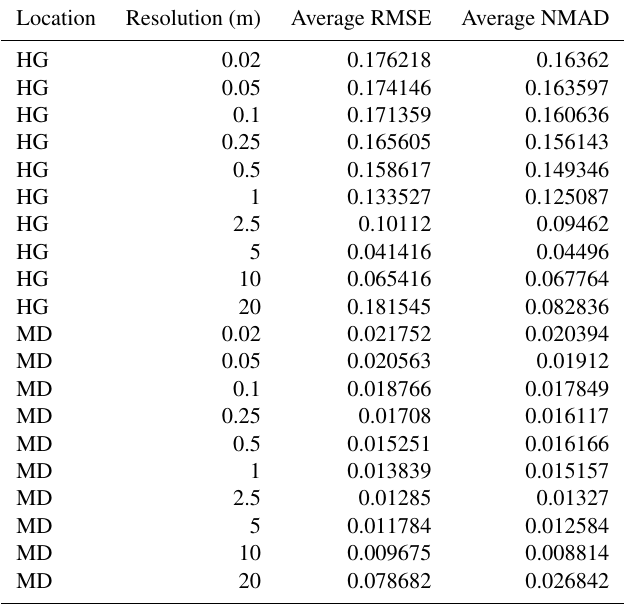
Figure A1. Snow depth uncrewed aerial systems (UAS)-derived er- ror (m) throughout the 2019–2020 winter field season. Each vari- able is calculated with all manually probed validation points and corresponding UAS-derived snow depths for each observation day.